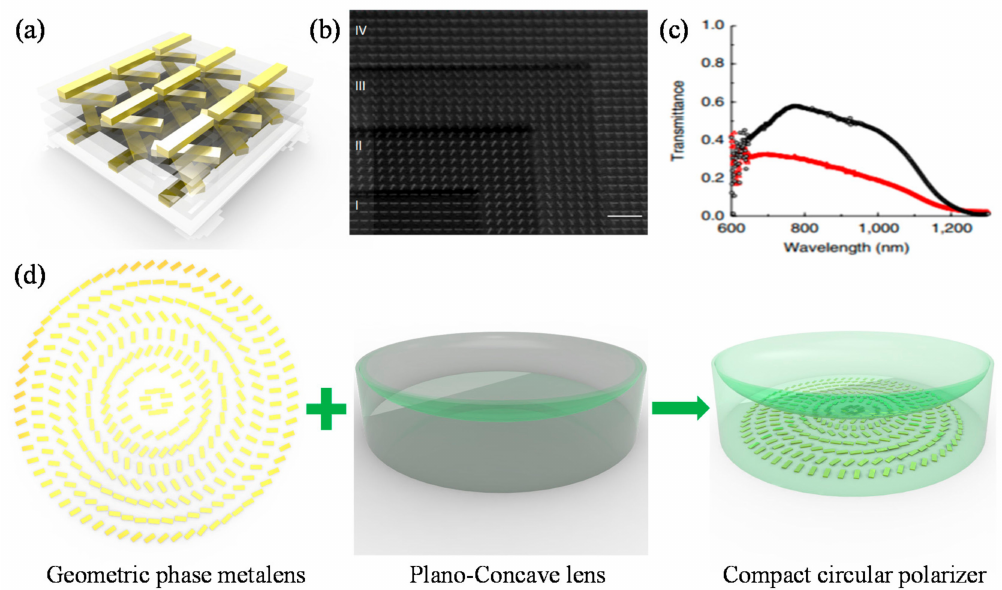
Figure 13. ( a ) Schematic illustration; and ( b ) ion beam assisted SEM image of rotationally stacked nanorod MM [165]; ( c ) Optical transmission spectra for LCP and RCP incidences. Black and Red curves refer to RCP and LCP, respectively; ( d ) Schemes of a geometric phase metalens, plano-concave dielectric lens, and hybrid compact circular polarizer [167]. Reprinted by permission from Macmillan Publishers Ltd.: (Nature Communications) (Reference [165]), copyright